Question: How would you classify this visualization?
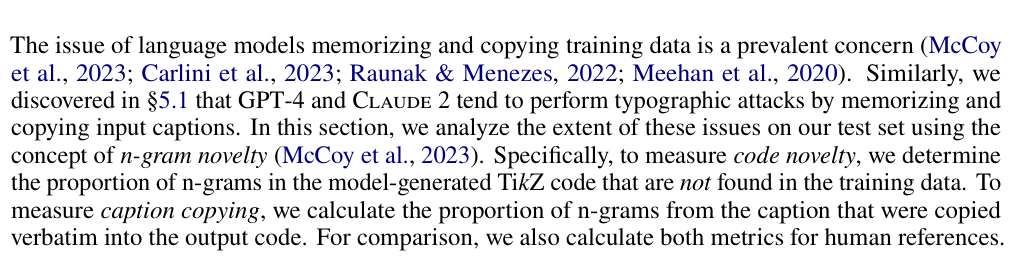
Answer: line